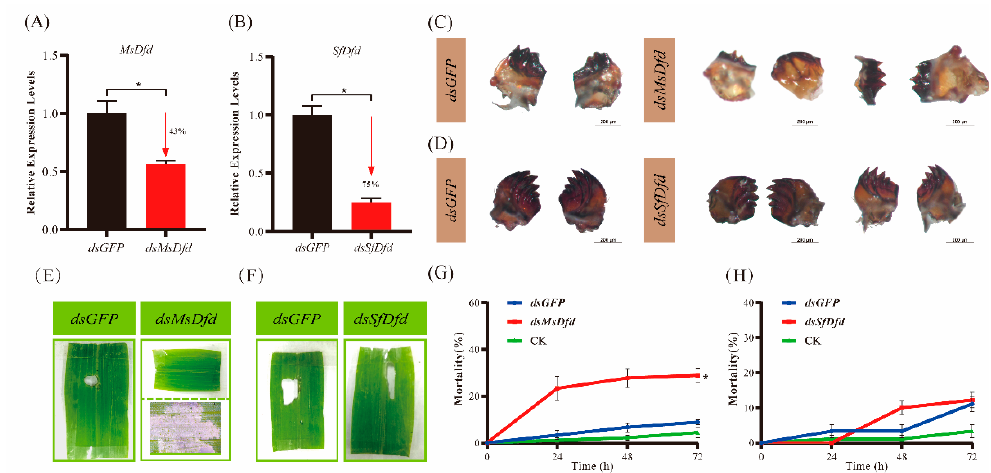
Figure 5. Functions of Dfds in larval mandible development and feeding behavior. Knockdown efficacy of MsDfd ( A ) and SfDfd ( B ). Differences of mRNA levels were analyzed by Student’s t -test ( p < 0.05), with * and red bar showing the significance. The arrow represents the decrease of mRNA levels. Morphological changes of mandibles after knockdown of MsDfd in M. separata ( C ) and SfDfd in S. frugiperda ( D ). Larval feeding changes after knockdown of MsDfd in M. separata ( E ) and SfDfd in S. frugiperda ( F ). Top panel for dsMsDfd : larvae cannot feed on the leaf; Bottom panel for dsMsDfd : larvae can only browse mesophyll ( E , G ) Mortality of newly first instar M. separata feeding on ds MsDfd -containing diet. ( H ) Mortality of newly first instar S. frugiperda feeding on ds SfDfd -containing diet.